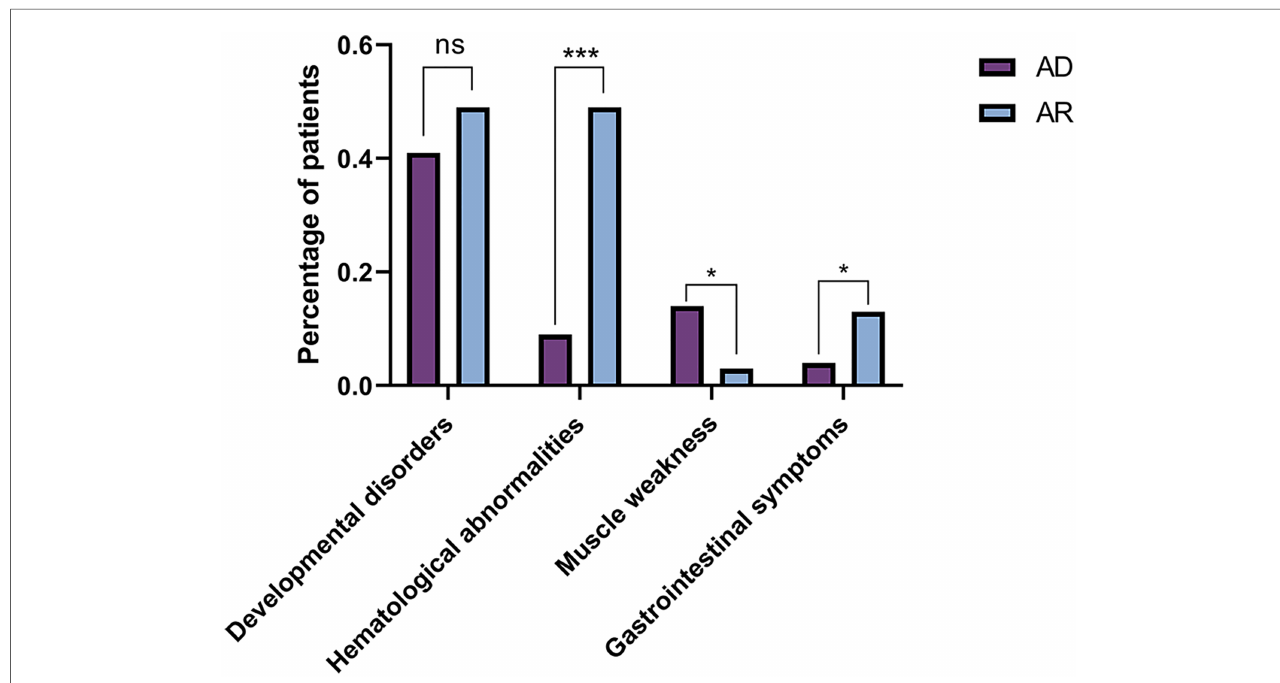
FIGURE 6 The comparisons of patients involving other organs between AD and AR. * P <0.05; *** P <0.001; ns: P